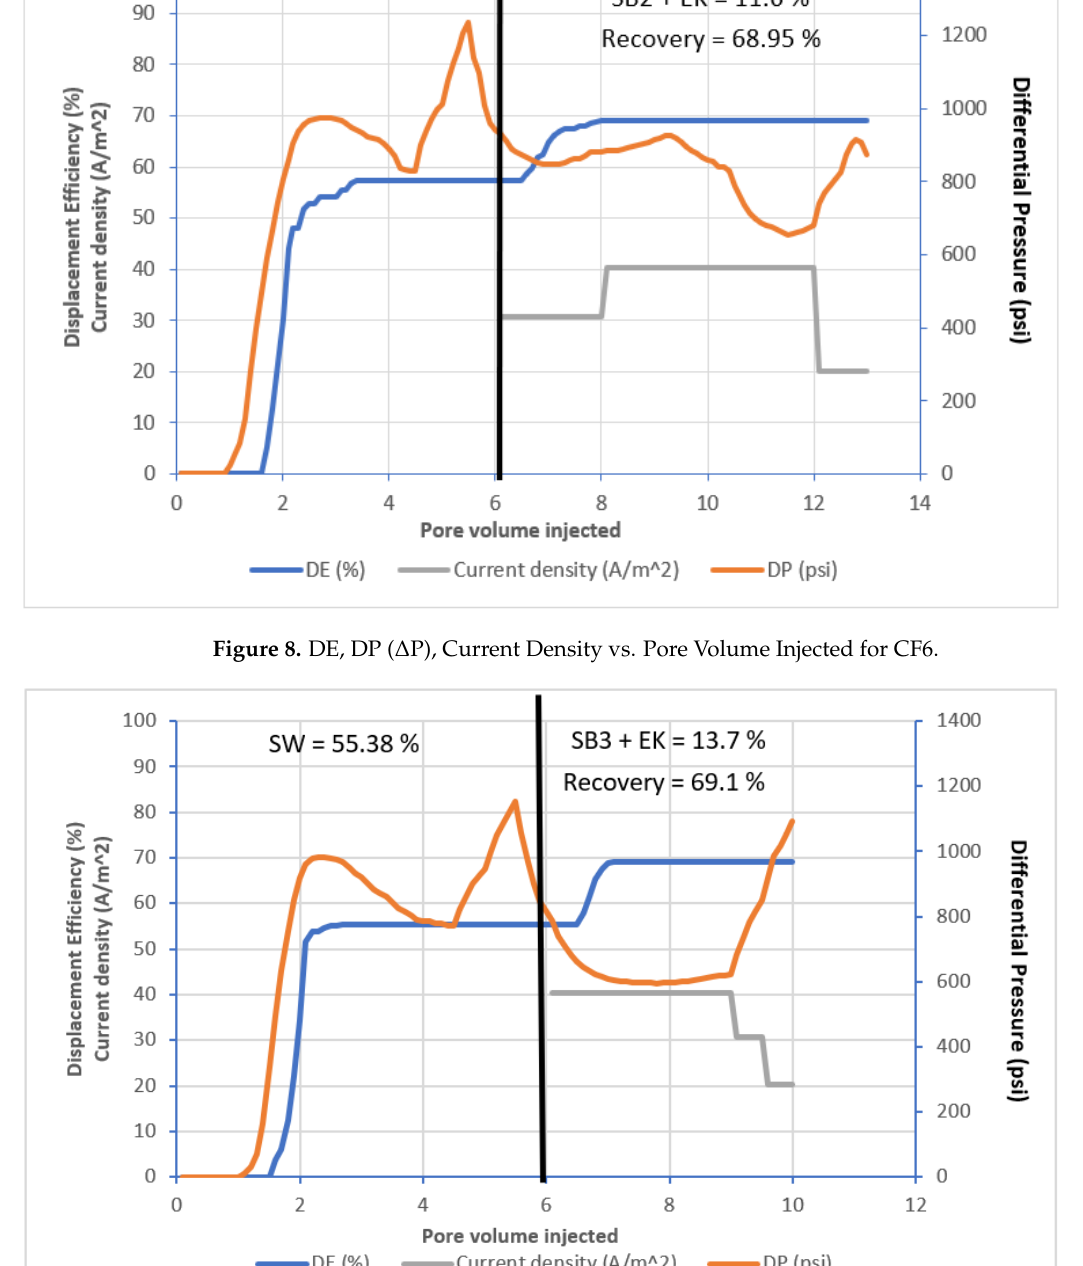
Figure 9. DE, DP (ΔP), Current Density vs. Pore Volume Injected for CF7 . Figure 9. DE, DP ( ∆ P), Current Density vs. Pore Volume Injected for